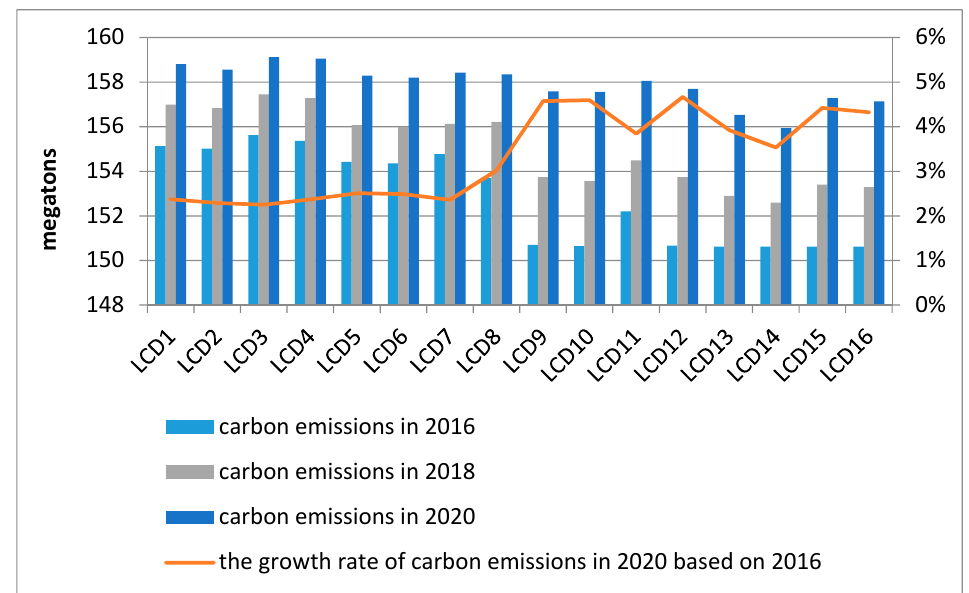
Figure 4. The prediction values of carbon emissions of Beijing for low carbon development scenarios in 2016, 2018 and 2020.